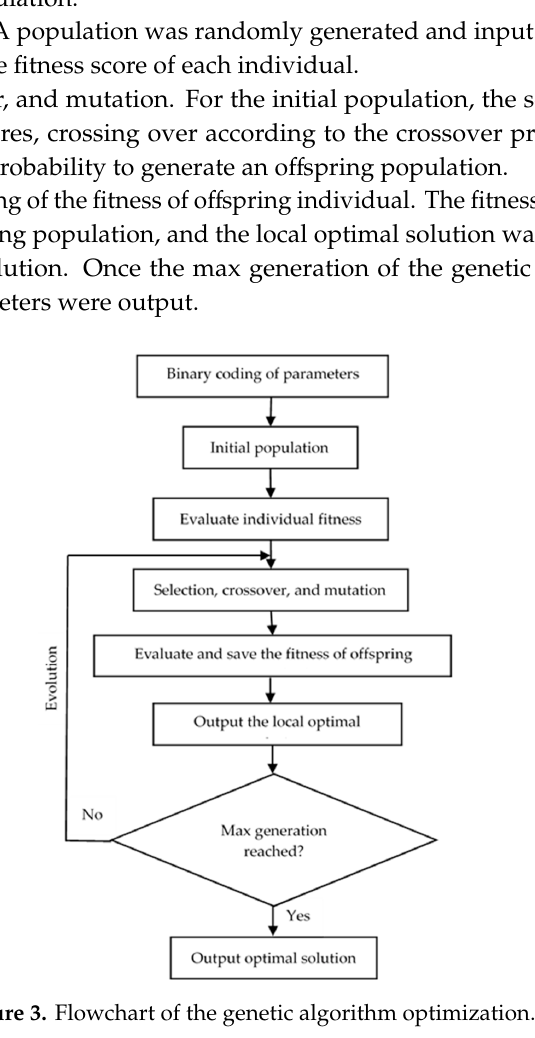
Figure 3. Flowchart of the genetic algorithm optimization.